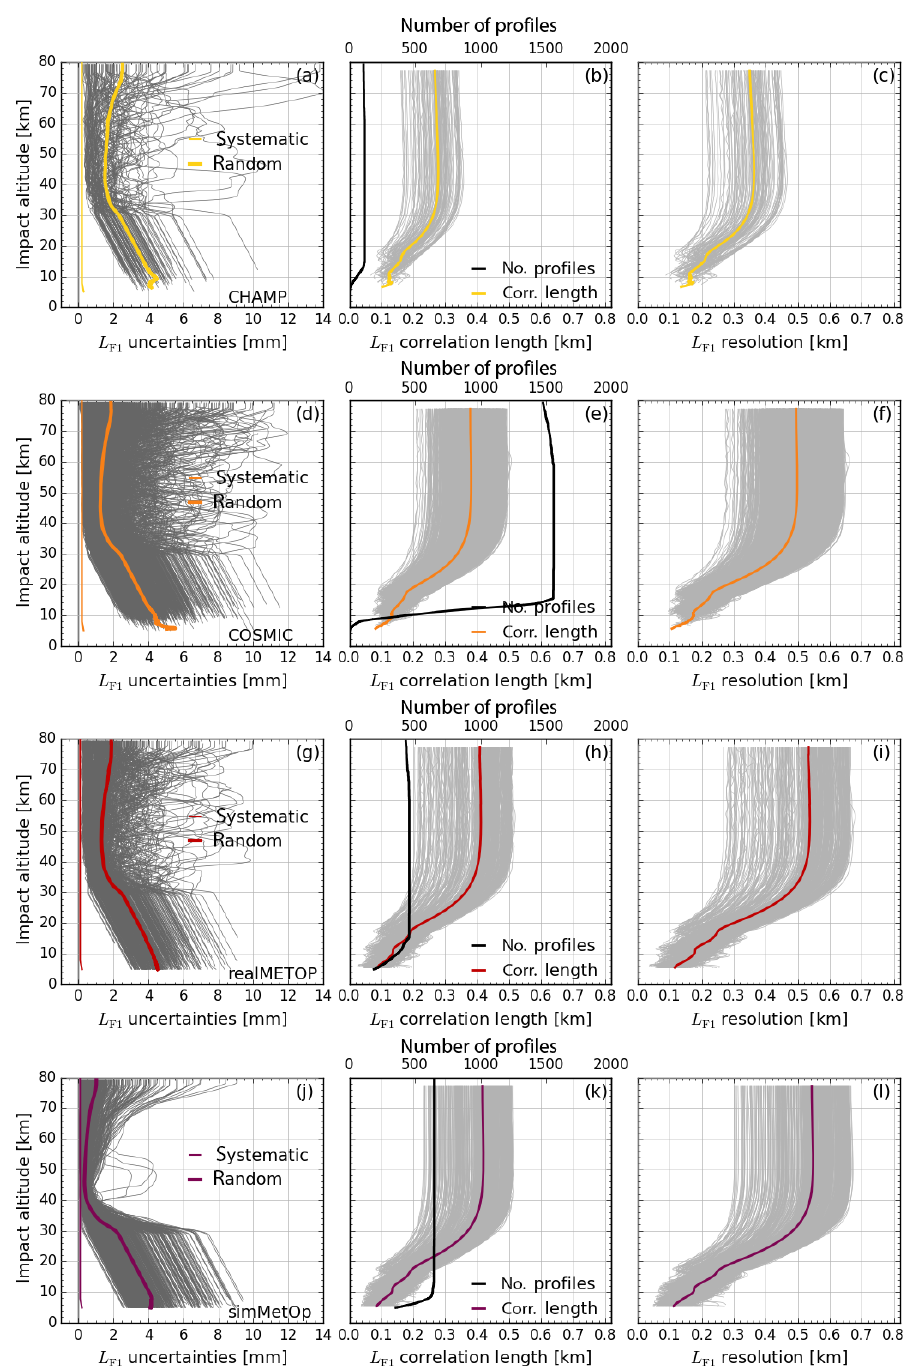
Figure 10. Uncertainty propagation results for real-data ensembles from 15 July 2008, for the filtered excess phase profile L F1 of the leading channel ( f T1 , GPS L1 frequency). Left column: estimated random u r (heavy) and systematic u s (light) uncertainty profiles of each L F1 L F1 ensemble member (gray), and the ensemble mean (color) for CHAMP (a) , COSMIC (d) , MetOp (g) , and simMetOp (j) . Middle column: correlation length profiles l L F1 of each ensemble member (gray), the ensemble mean (color), and the ensemble size profile (black, scale at upper axis) for CHAMP (b) , COSMIC (e) , MetOp (h) , and simMetOp (k) . Right column: estimated resolution profile w L F1 of each ensemble member (gray) and the ensemble mean (color) for CHAMP (c) , COSMIC (f) , MetOp (i) , and simMetOp (l)